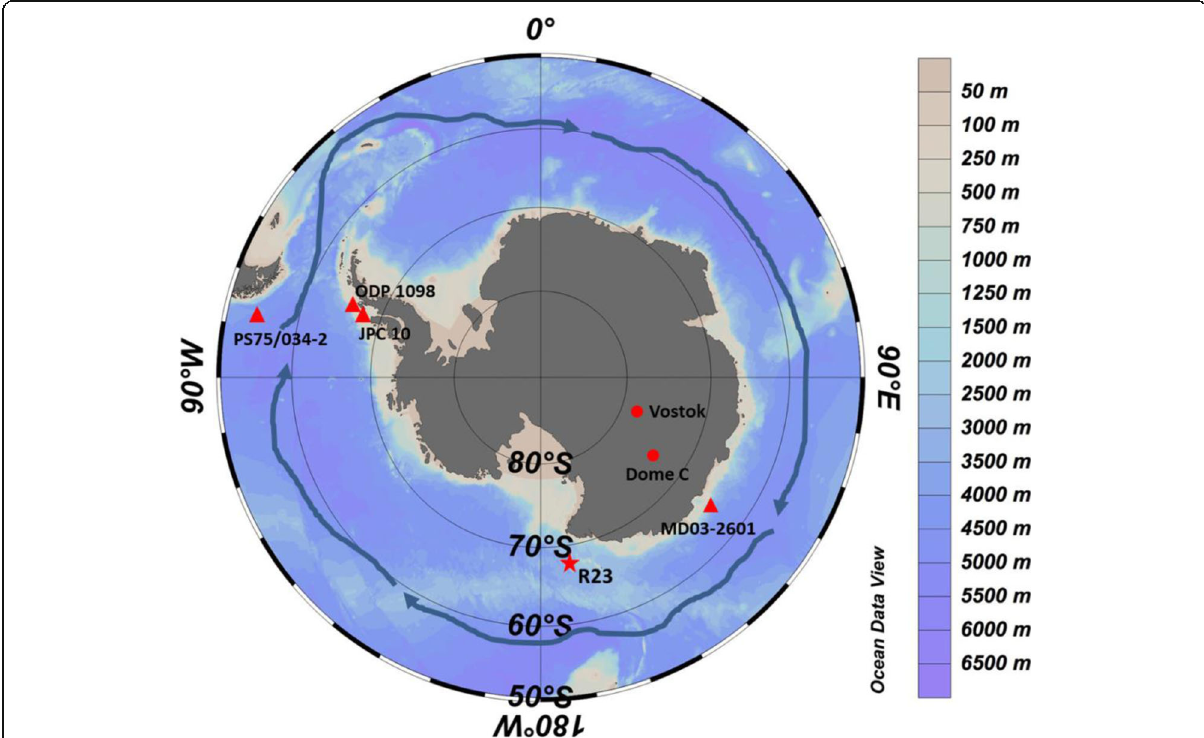
Fig. 1 Map of the Southern Ocean and the continent of Antarctica. The red pentagram denotes the core R23 in our study. Red triangles indicate sites of sea surface temperature or sea subsurface temperature records reported in previous studies. The SST record in the PS75/034-2 sediment index (Ho et al. 2012), whereas other sediment cores (ODP 1098, JPC 10, and MD03-2601) were used for TEX 86 core was used for the U k 37 (Shevenell et al. 2011; Kim et al. 2012; Etourneau et al. 2013). The thick blue line indicates the Antarctic Circumpolar Current (ACC). The solid dots denote ice core locations in the Antarctic, including Dome C and